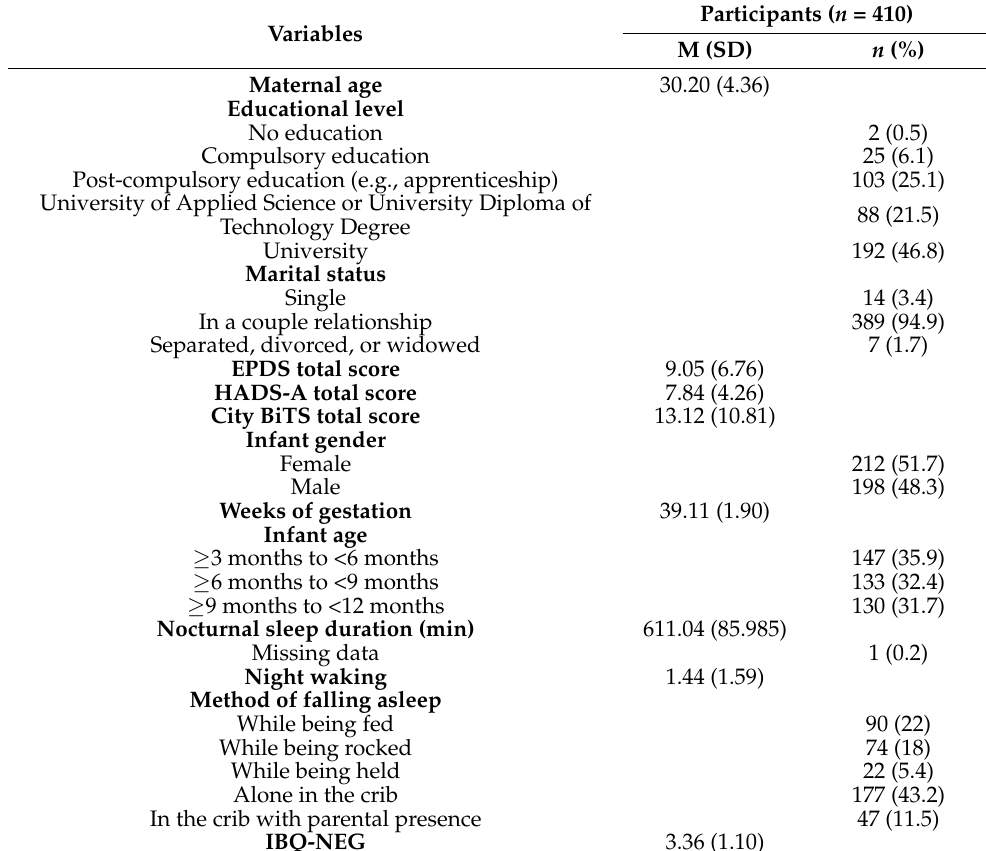
Table 1. Descriptive Characteristics of the Sample.